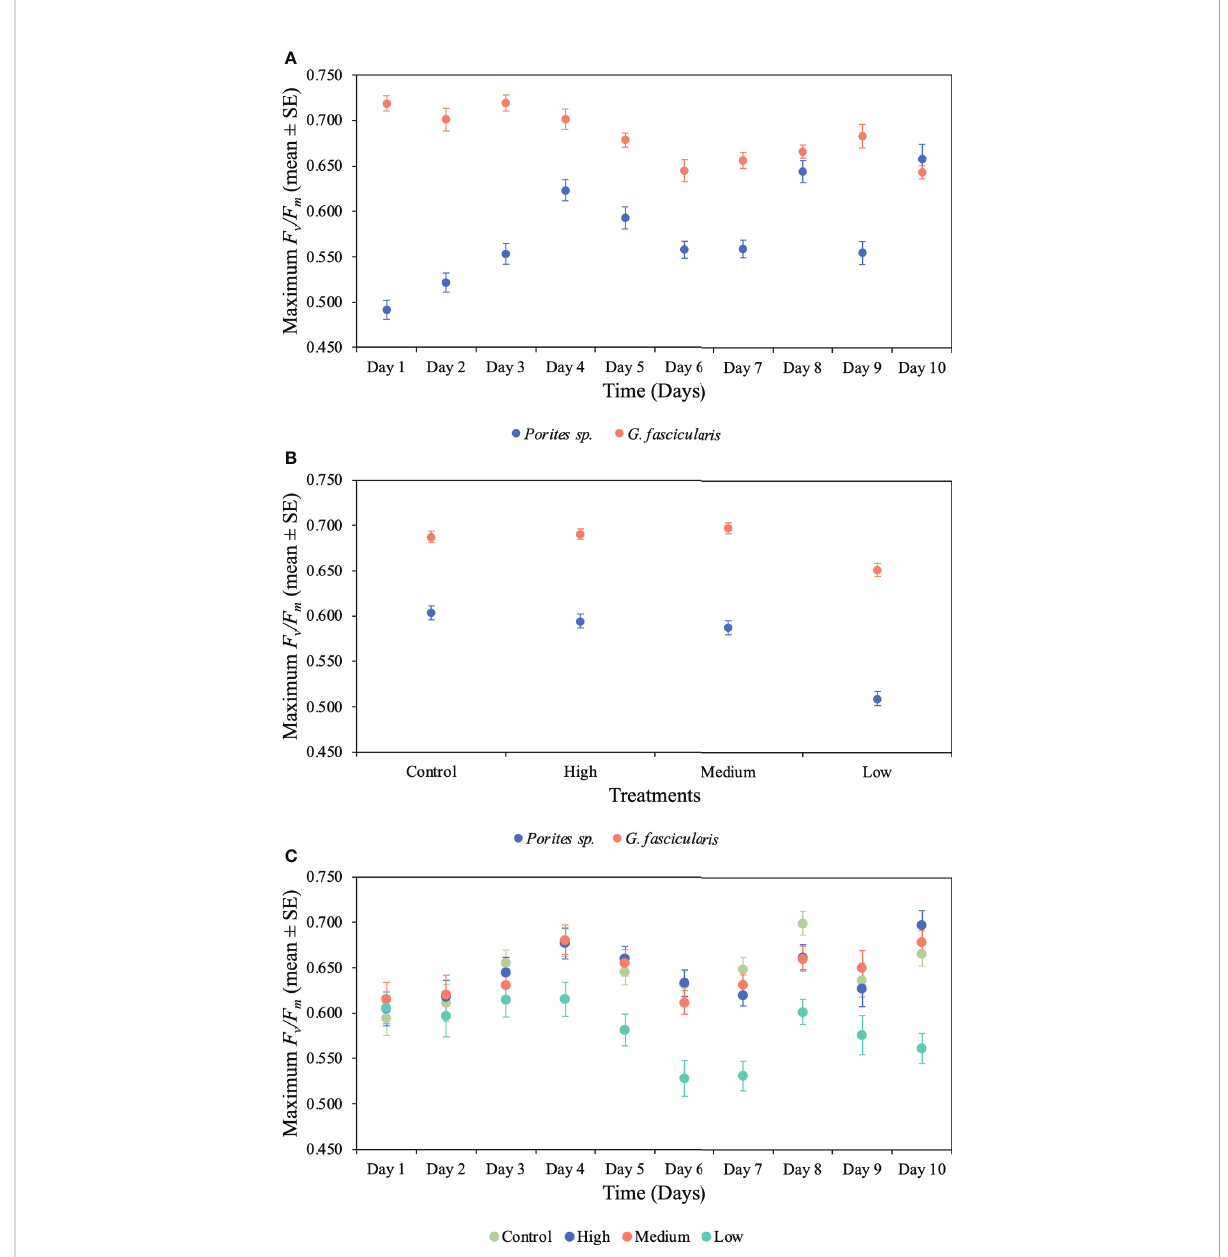
FIGURE 4 Mean (± 1SE) rates of maximum photochemical ef fi ciency ( F v / F m ) and its interaction between (A) species and time for Porites sp. and G. fascicularis throughout the 10 days of the experiment ( p < 0.001), (B) species and different O 2 treatments ( p = 0.009), and (C) time and O 2 treatment for Porites sp. and G. fascicularis throughout the 10 days of the experiment ( p =